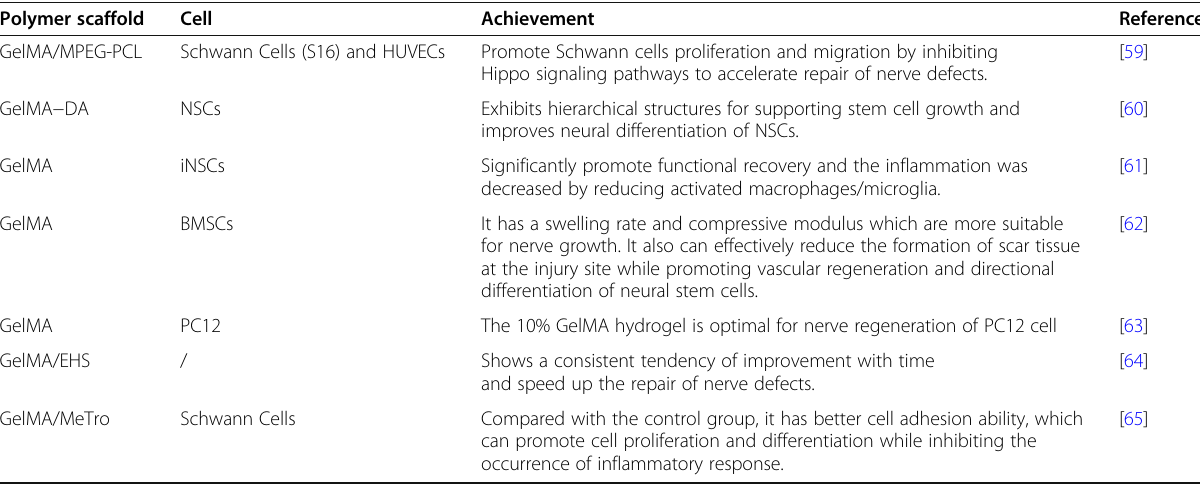
Table 2 The recent application of GelMA in nerve regeneration engineering Polymer